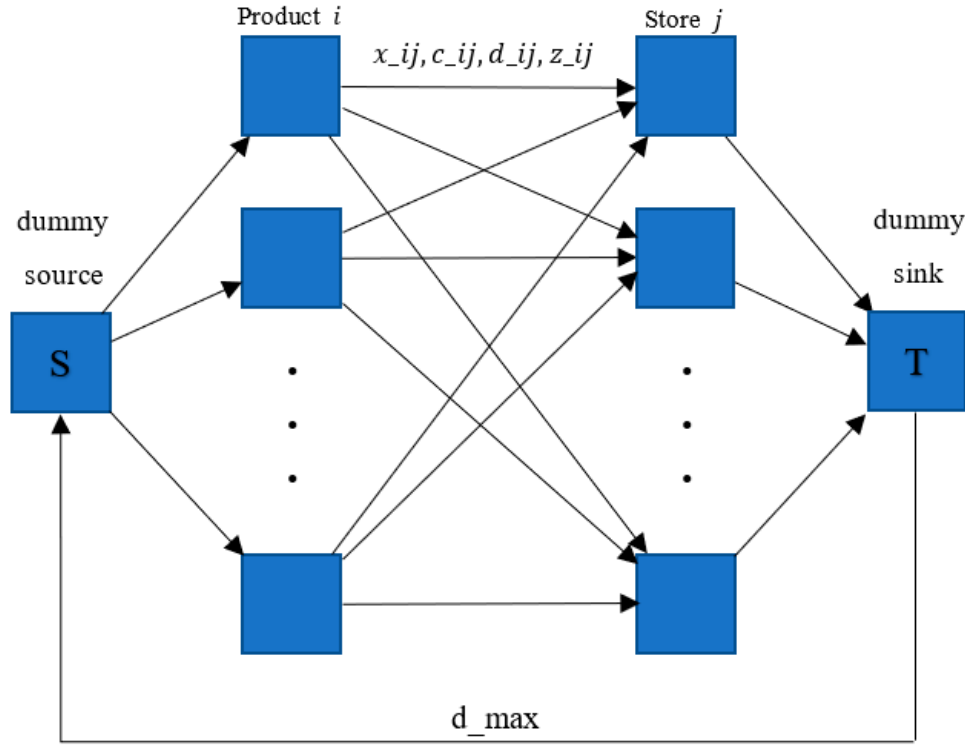
Figure 2. Network illustration of ISOP as MFP-CD.